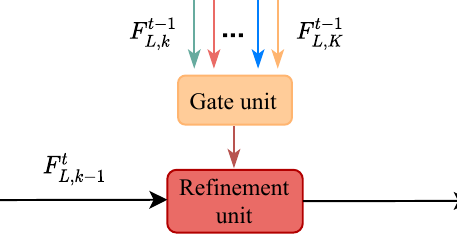
Figure 4. Architecture of the GF